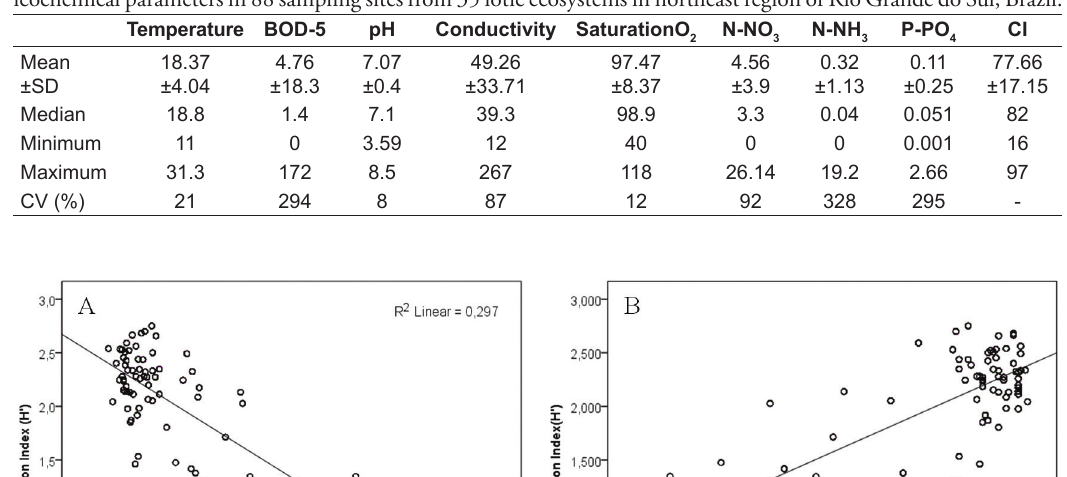
Table 1. Mean, standard deviation (±SD), median, minimum, maximum and Coefficient of Variation (CV) of phys-